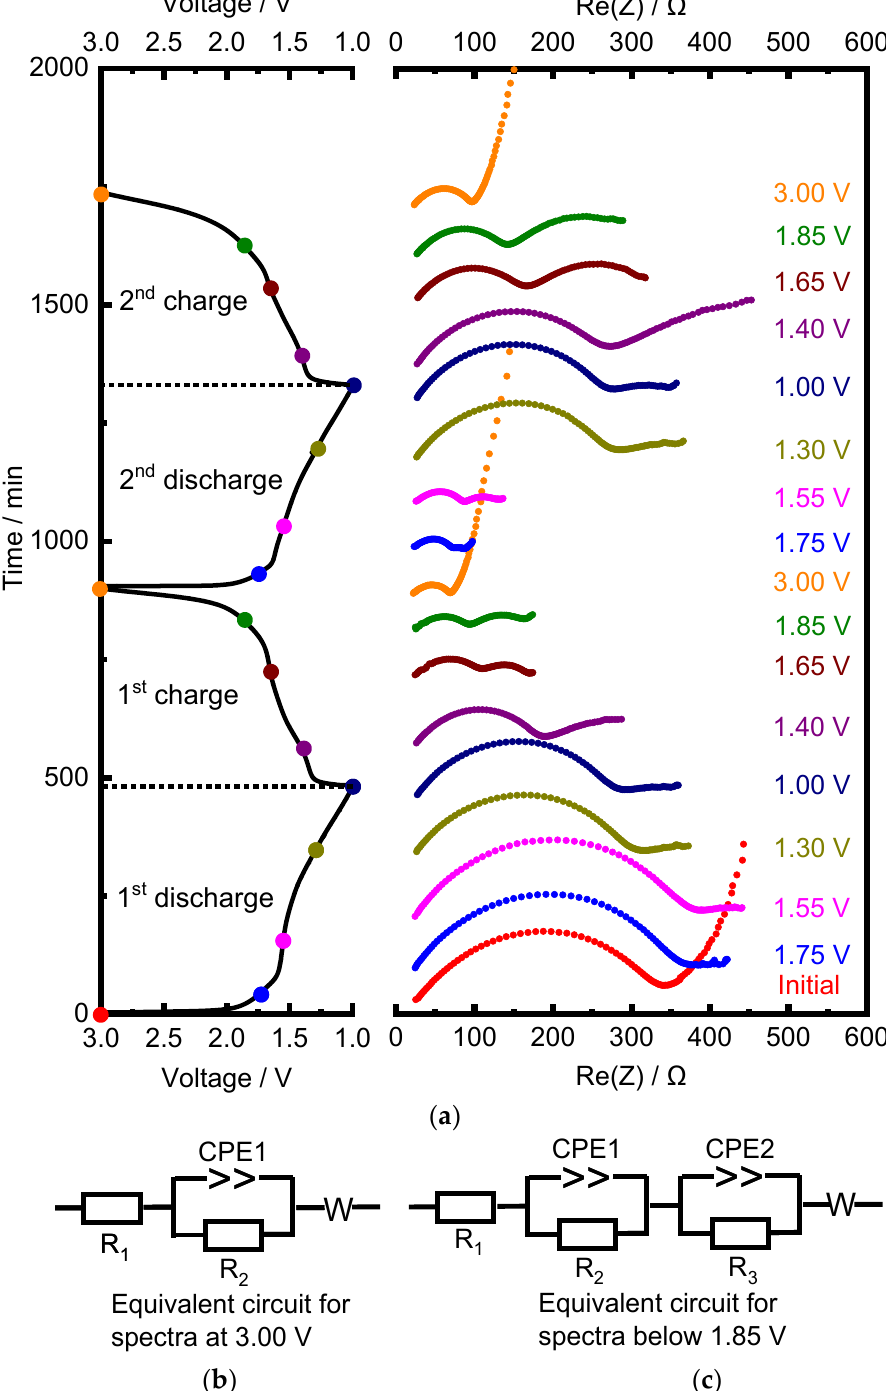
Figure 10. ( a ) In situ EIS spectra of TNO upon first two cycles at different states of charge and discharge in combination with the cycling curve and ( b , c ) corresponding equivalent circuits.